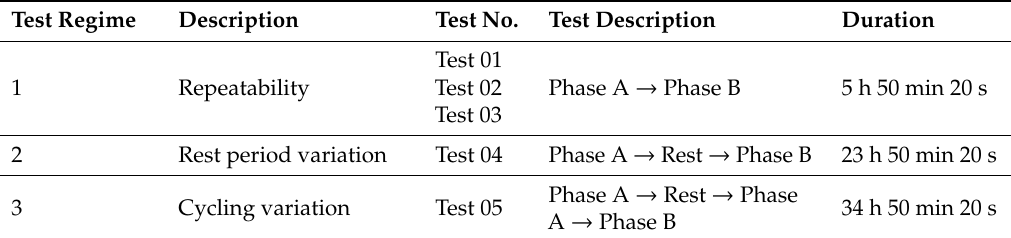
Table 5. Description and duration of the test regimes employed for RRT of a fibre